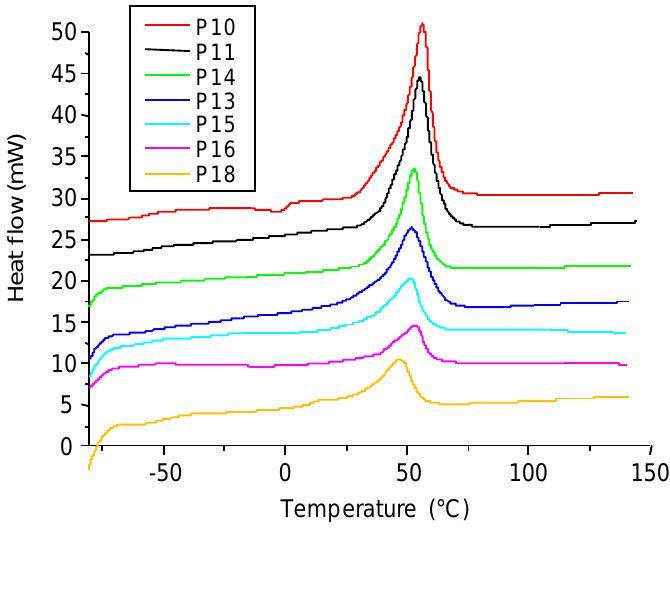
Figure 1. DSC curves for selected SMPs.